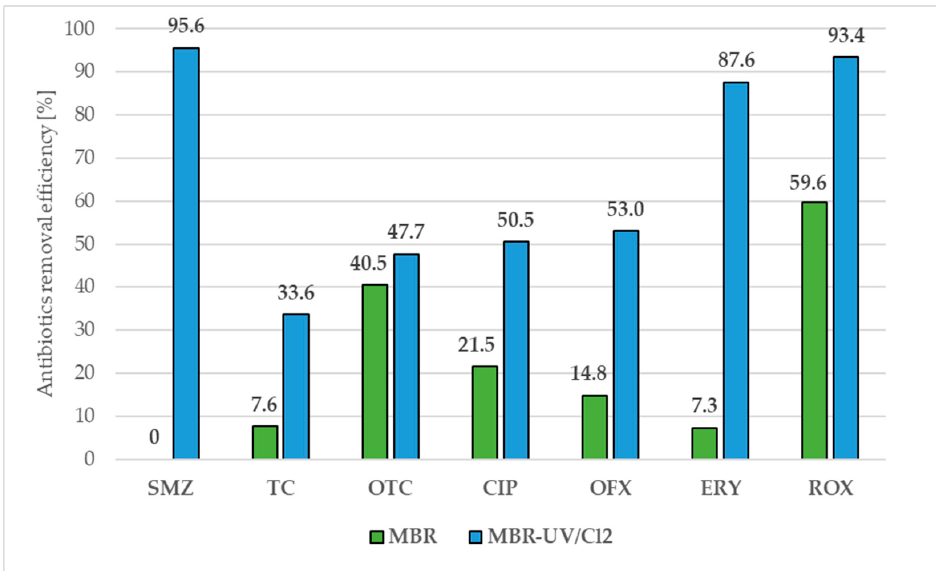
Figure 3. Antibiotic removal efficiency by MBR and MBR-UV/Cl 2 processes [143]. SMZ—sulfamethoxazole, TC—tetracycline, OTC—oxytetracycline, CIP—ciprofloxacin, OFX—ofloxacin, ERY—erythromycin, ROX—roxithromycin.